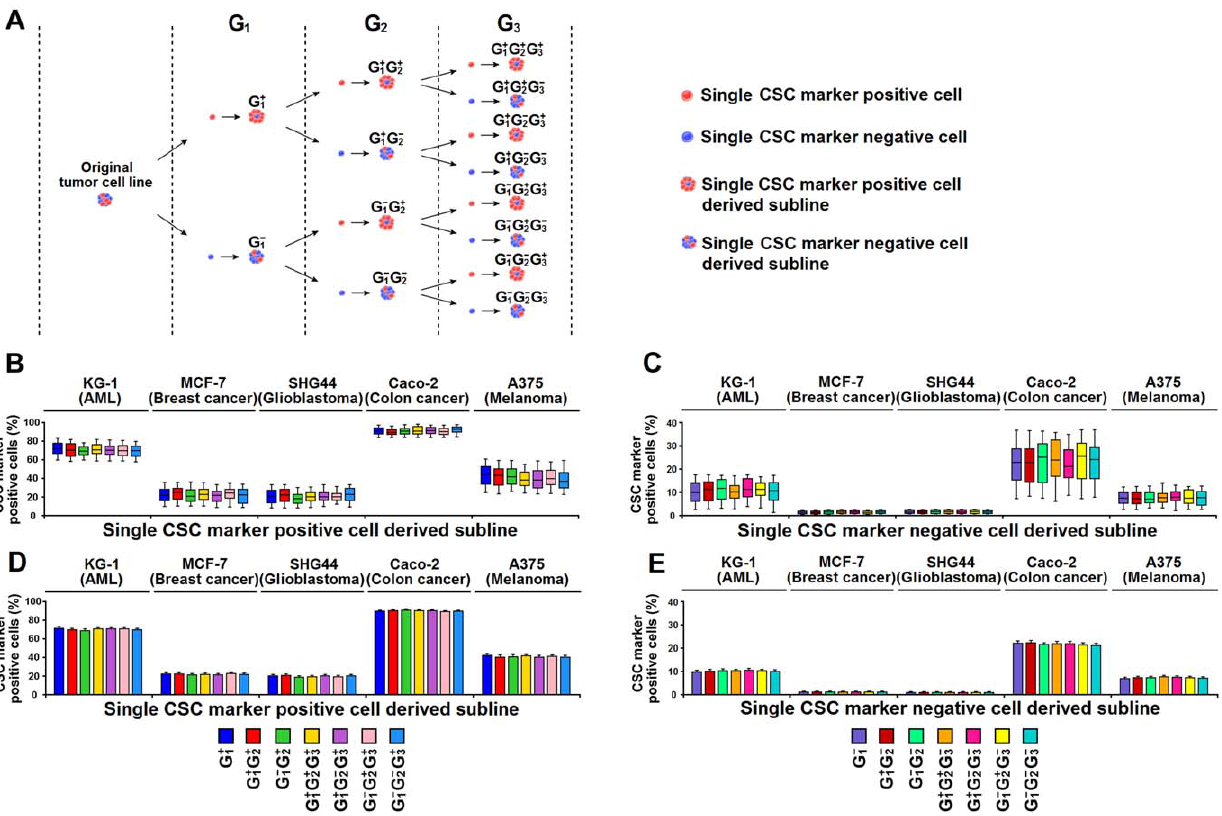
Figure 5. There is no CSC marker based hierarchy in CSC marker expressing tumors. ( A ) Schematic diagram shows the construction of serial single-cell derived sublines (SCDSLs). CSC + and CSC 2 cells from the original tumor cell lines were selected to generate SCDSLs and arbitrarily classified as generation 1 SCDSLs (including G 1 + and G 1 2 ). CSC + and CSC 2 cells from G 1 SCDSLs were selected to generate G 2 SCDSLs (including G 1 + G 2 + , G 1 2 G 2 + , G 1 + G 2 2 and G 1 2 G 2 2 ). We repeated the procedure until G 3 SCDSLs were obtained. (B–E) The percentage of CSC marker positive cells in SCDSLs from KG-1, MCF-7, SHG44, Caco-2 and A375 was analyzed by flow cytometry when the cell quantity reached approximately 1 6 10 6 . Box plots show the percentage of CSC marker positive cells in single CSC + -derived ( B ) and CSC 2 -derived ( C ) sublines from different generations, with the whiskers representing the minimum and maximum values, the central lines representing the median value, and the boxes representing the 25th and 75th percentile. Histograms show the percentage of CSC marker positive cells in single CSC + -derived ( D ) and CSC 2 -derived ( E ) sublines from different generations. Data represent mean 6 SEM from 100 samples, each from one independent serial SCDSL construction.